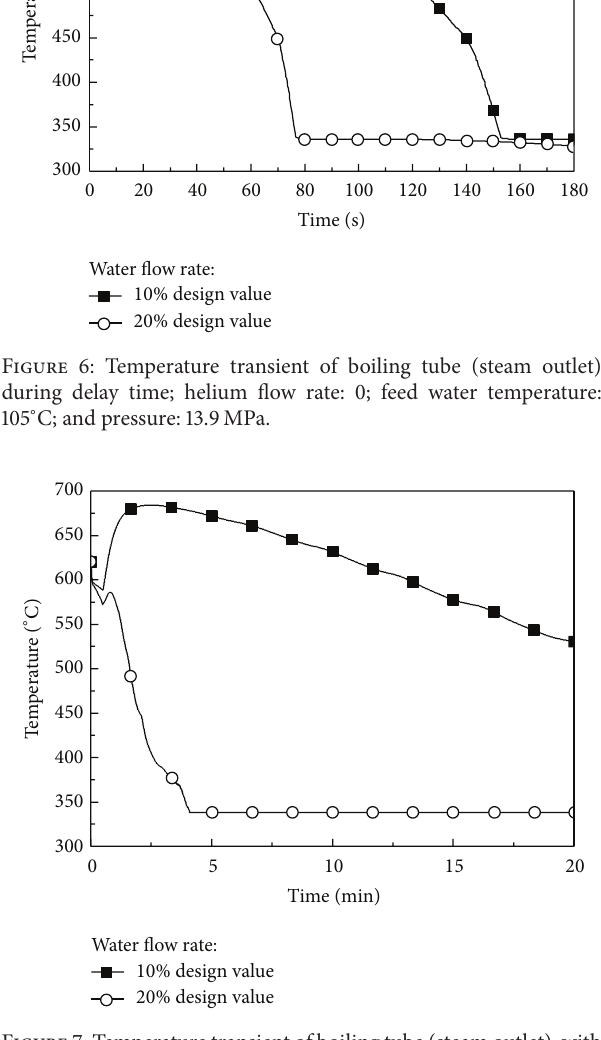
Figure 7: Temperature transient of boiling tube (steam outlet), with 30 s delay of helium circulation; helium flow rate: 10% design value; feed water temperature: 105 ∘ C; and pressure: